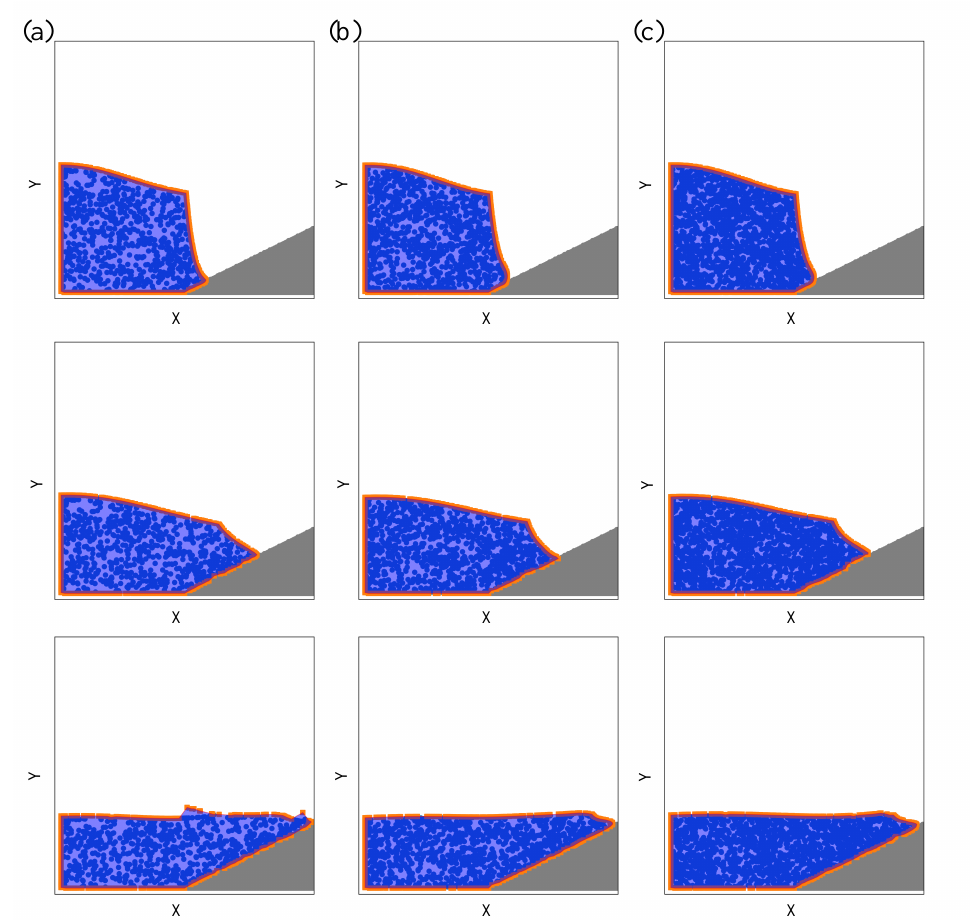
Figure 9. Surface particle identification for fluid climbing with different densities and randomly distributed particles at t = 0.14, 0.36, and 0.56 s. ( a ) Results from n = 700; ( b ) Results from n = 1000; ( c ) Results from n =